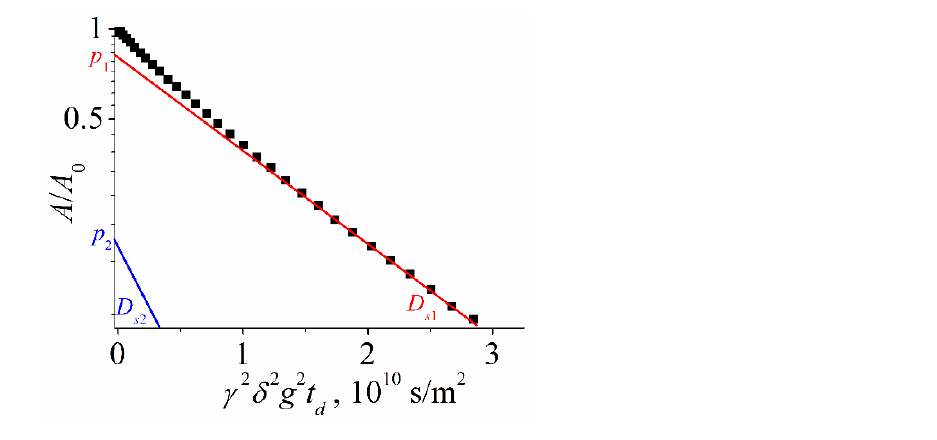
Figure 4. Diffusion decay of the fullerene derivative VII in D 2 O solution at t d = 20 ms, C = 6 mg/mL. The hydrodynamic diameters d H based on each self-diffusion coefficient were calcu- lated from Equation (2) and are given in Table 3. Table 3. The self-diffusion coefficients D s 1 , D s 2 , populations p 1 , p 2 , and the hydrodynamic diameters d H 1 , d H 2 of the aggregates formed by the compound VII in deuterated water solutions.